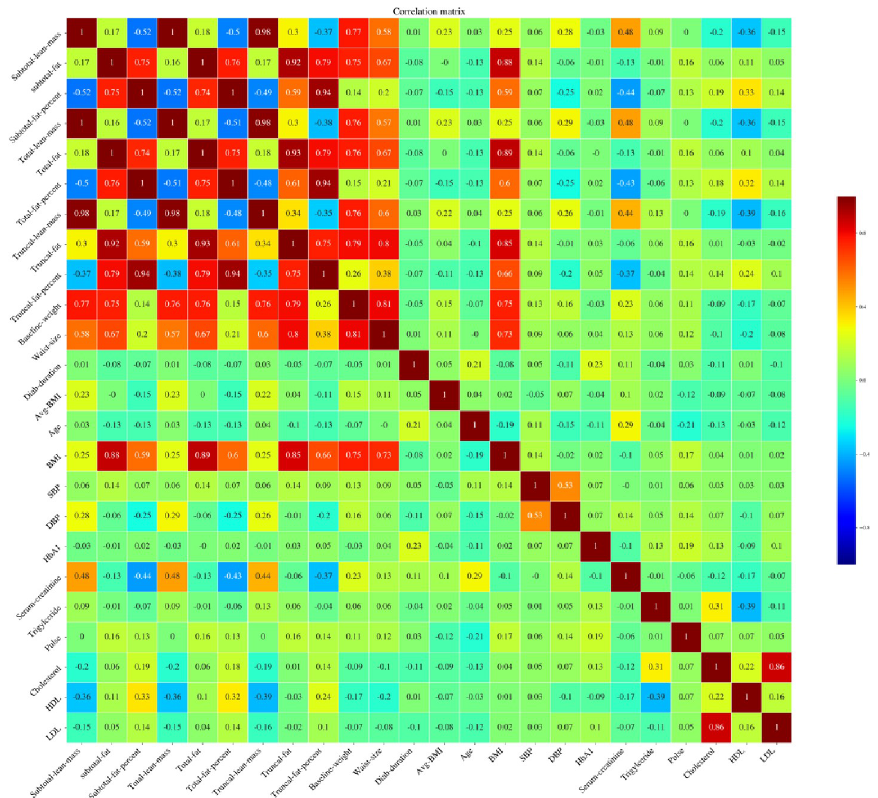
Fig 2. Correlation matrix of all the variables initially chosen for predicting the exercise capacity. Any of these variables with correlation greater than 0.55 are eliminated before feeding them to the machine learning algorithms.